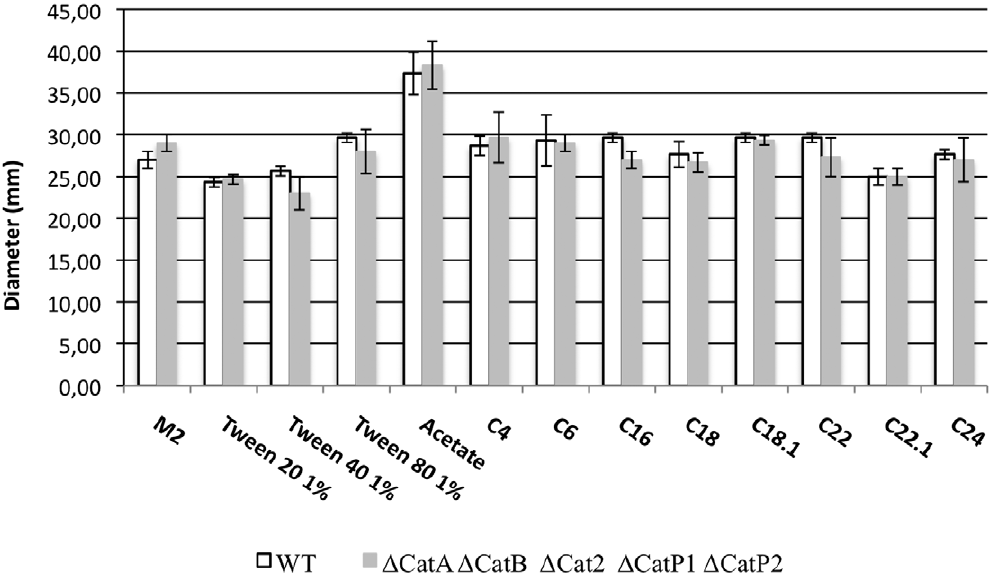
Figure 2. Growing rates of wild type and the quintuple catalase mutants on fatty acids. Thalli diameters (mm) for each strain were measured 72 hours after incubation on solid medium at 27 u C. The minimal synthetic medium was used and contains either 0.5% (V/V) dextrin (M2) or various fatty acids as carbon sources: 1% (V/V) Tween20, 1% (V/V) Tween40, 1% (V/V) Tween80, 50 mM acetate, 30 mM butyric acid (C4), 20 mM hexanoic acid (C6), 7.5 mM palmitic acid (C16), 6 mM stearic acid (C18), 6 mM oleic acid (C18:1), 5 mM behenic acid (C22), 5 mM erucic acid (C22:1) and 5 mM lignoceric acid (C24). C16, C18, C18:1, C22, C22:1 and C24 were solubilized with 0.5% (V/V) tergitol NP40. When required, pH was adjusted to 7. The value for each strain is an average of 6 cultures and error bars represent standard deviation.